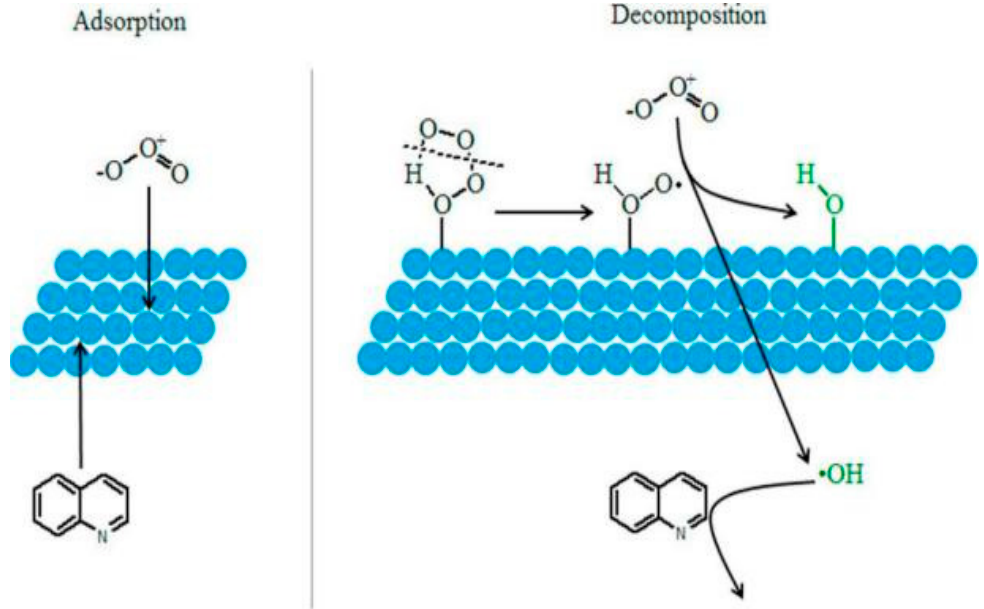
Figure 7. Mechanism of quinoline degradation in catalytic ozonation.